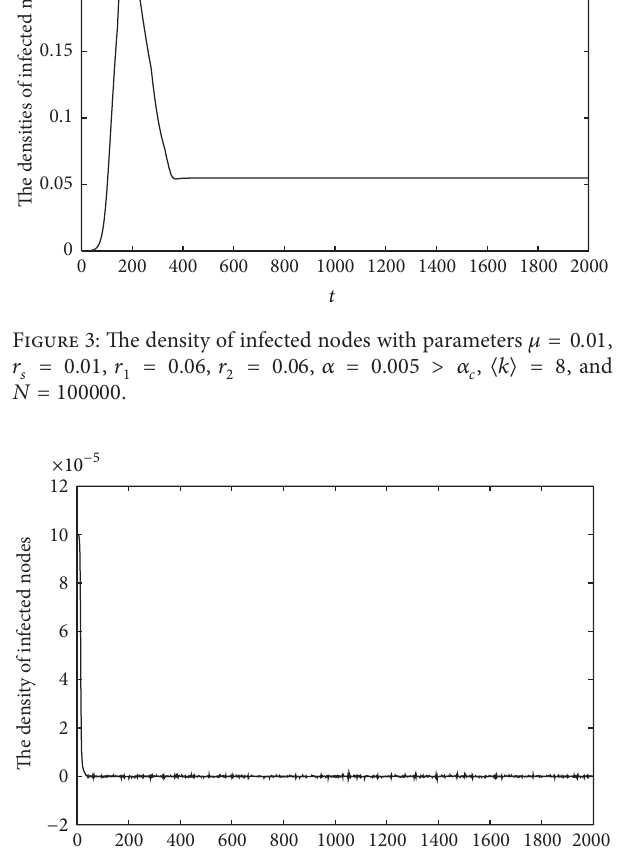
0 Figure 6: An illustration of the impact of antivirus software ( 𝛿 ) on the density of infected